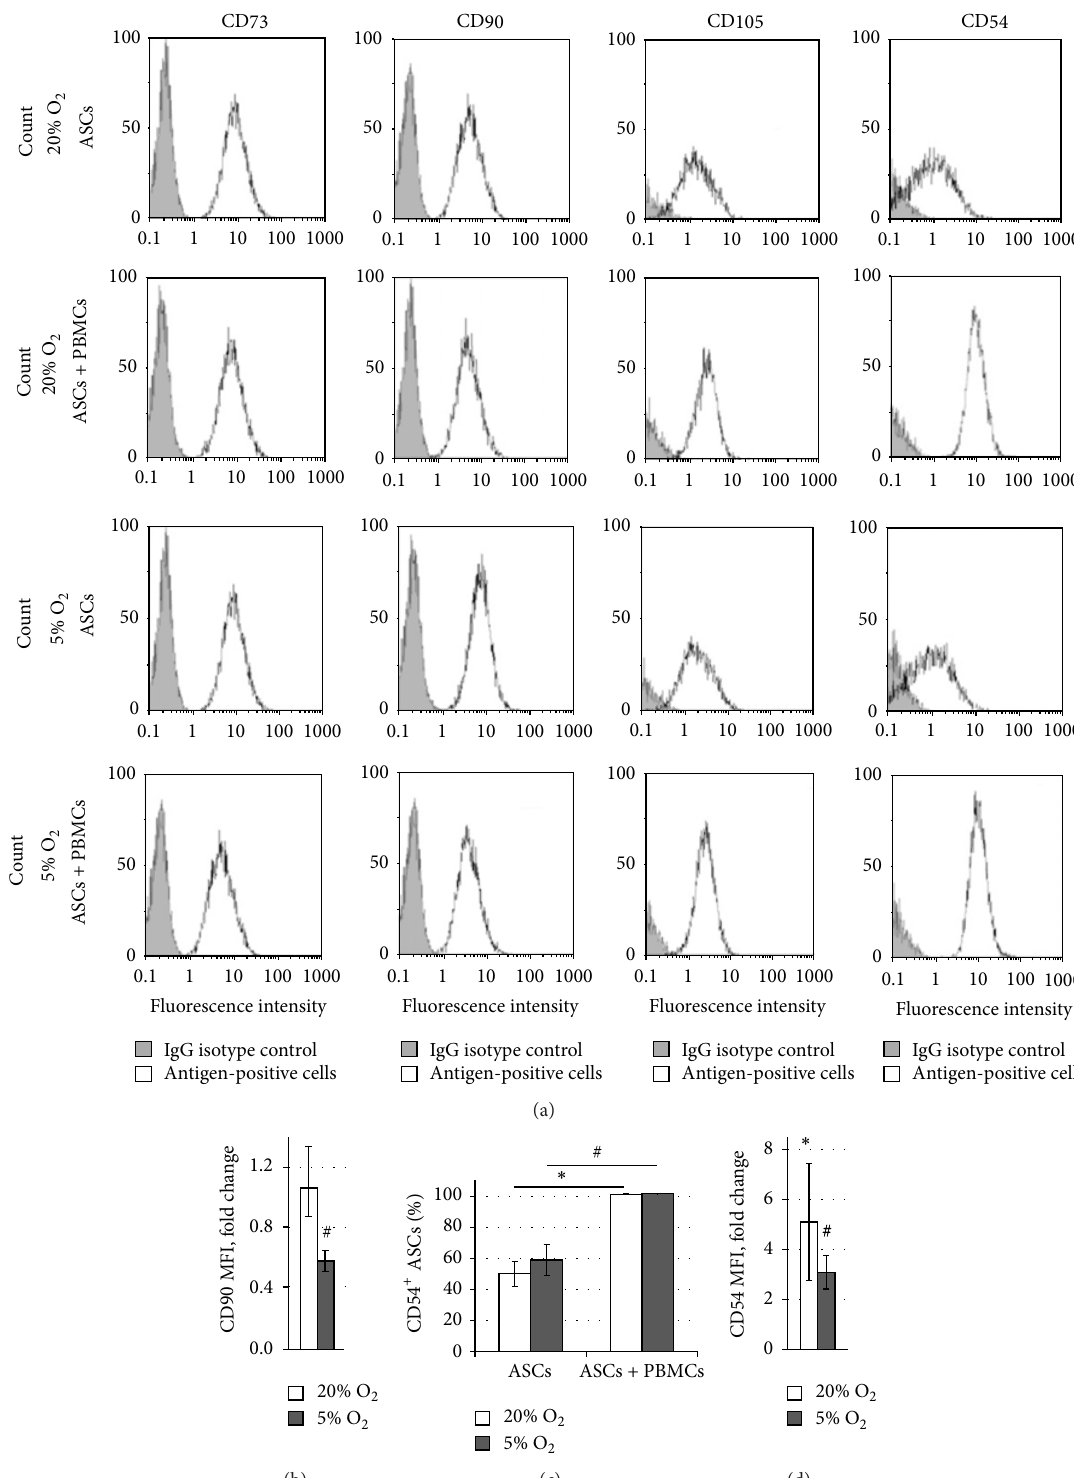
Figure 2: ASC immunophenotype after monoculture and transwell coculture with PHA-stimulated PBMCs under 20% and 5% O 2 . (a) Representative histograms of ASC surface marker expression. The white filled histograms indicate the positively stained cells while the grey filled histograms indicate the isotype-matched antibody controls. (b) CD90 mean fluorescence intensity (MFI) on cocultured ASCs versus ASCs in monoculture. (c) The proportion of CD54-positive ASCs in monoculture and transwell coculture with PBMCs. (d) CD54 MFI on cocultured ASCs versus ASCs in monoculture. ∗ Significant difference between monoculture and coculture at 20% O 2 ( 𝑝 < 0.01 ). # Significant difference between monoculture and coculture at 5% O 𝑝 < 0.01 2 (